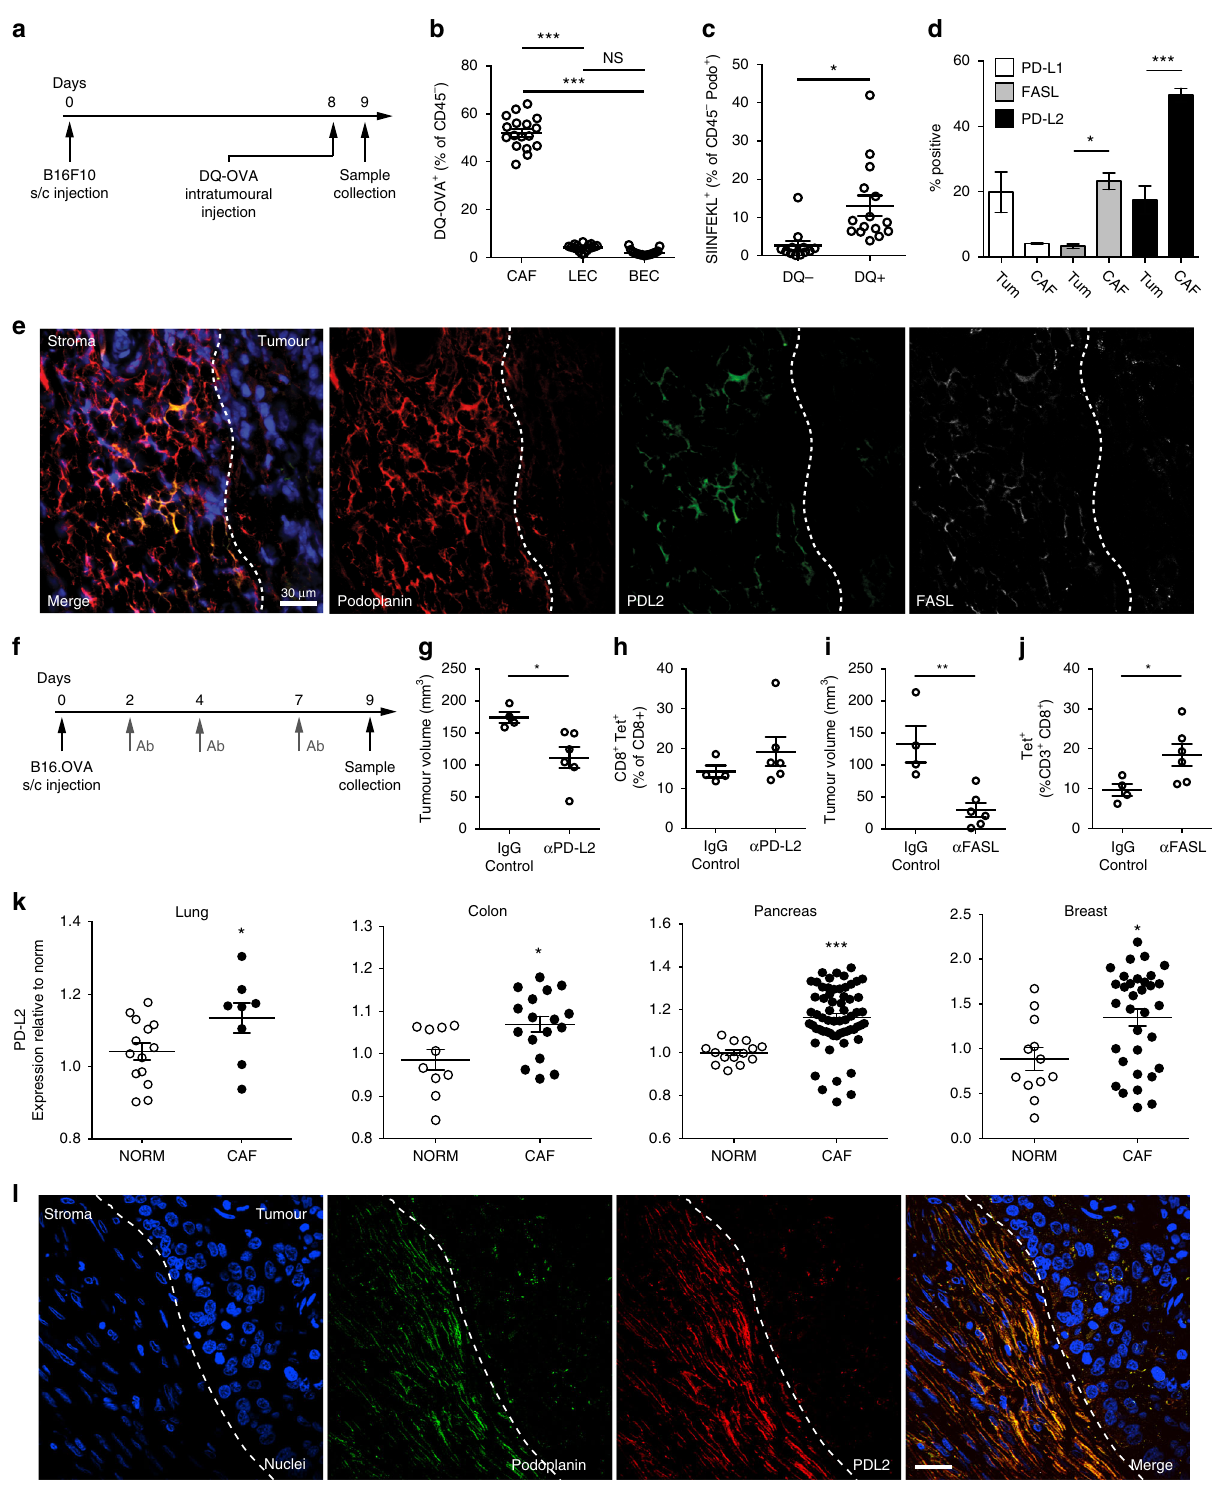
two key features: fi rst, fi broblasts sample, process and cross- present antigen complexed with MHC I. Second, co-incident antigen-speci fi c upregulation of FAS/FASL and PD-1/PD-L2 on T cells and CAFs respectively, drives the death and dysfunction of tumour speci fi c T cells resulting in enhanced tumour via- bility. Together with human data demonstrating PD-L2 and